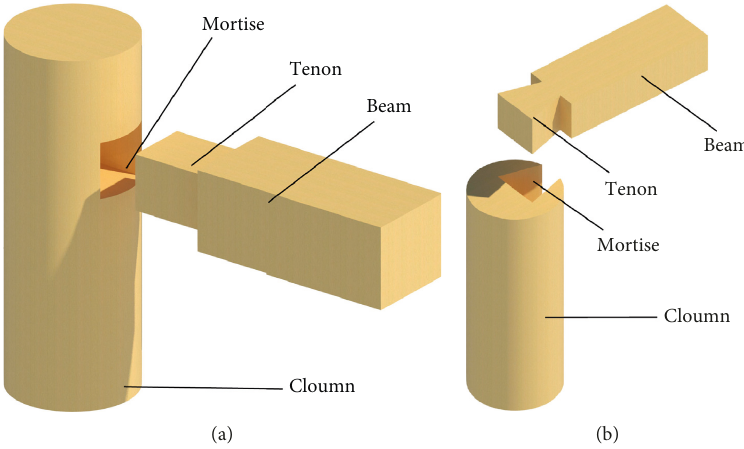
Figure 1: Joints in Chinese ancient timber building. (a) Straight tenon joint and (b) dovetail